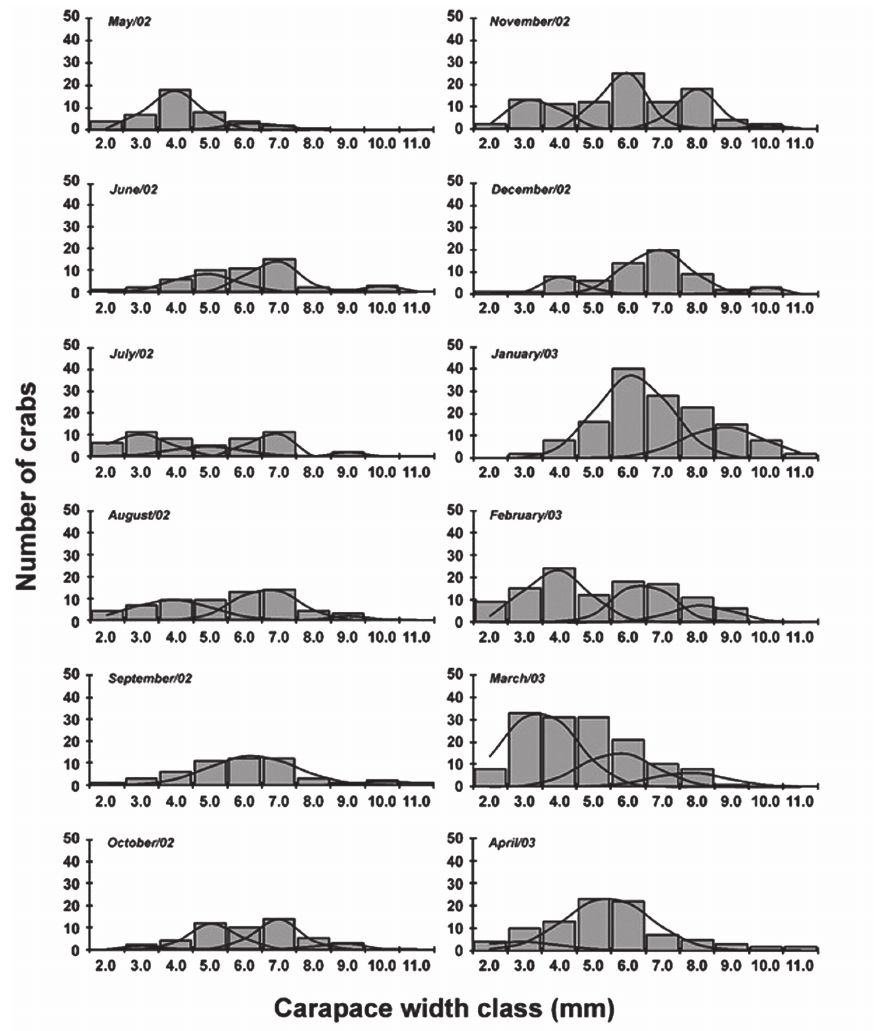
Figure 6. Monthly size frequency distribution of Panopeus austrobesus , indicating the modal curve evaluation, in the mussel farm at Itaguá Beach, Ubatuba, State of São Paulo,